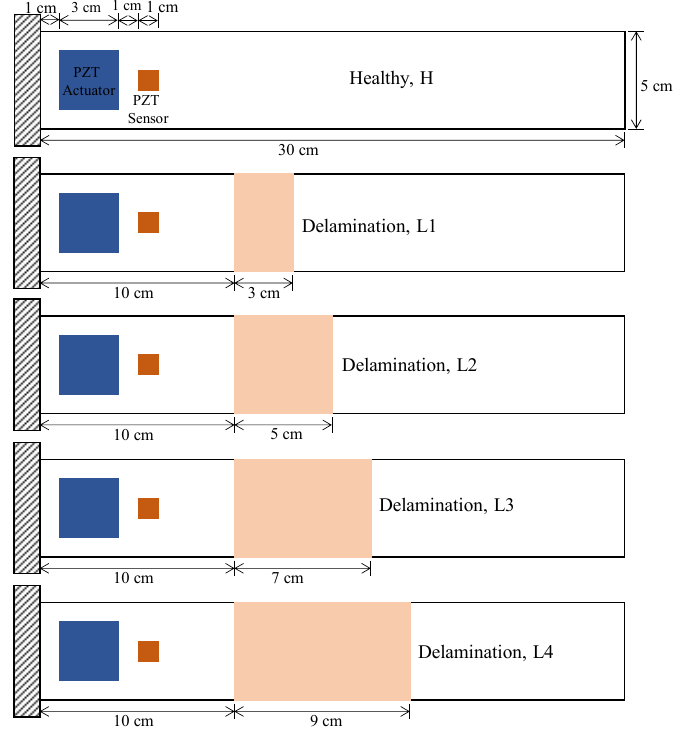
Figure 2. Geometric configuration of laminated composite plate in numerical simulations.